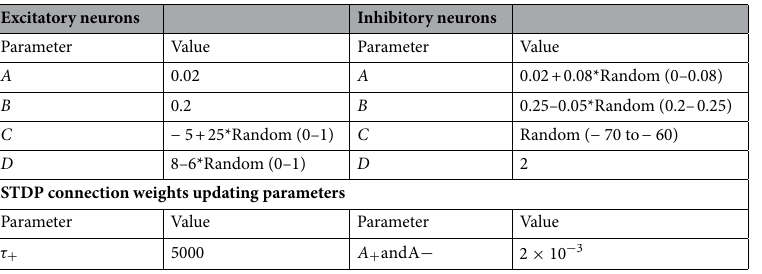
Table 1. Simulation Parameter Values for the Izhikevich type of neurons and STDP